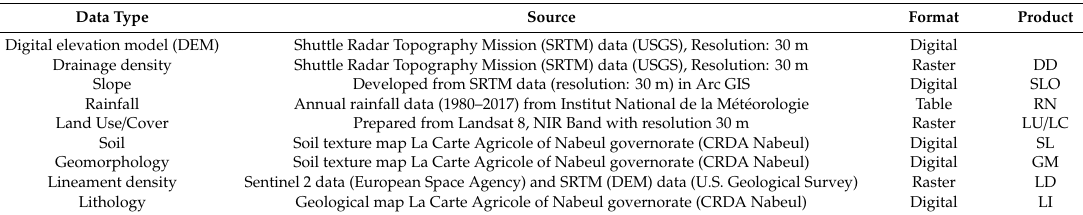
Table 1. Summary of data, sources and purpose of